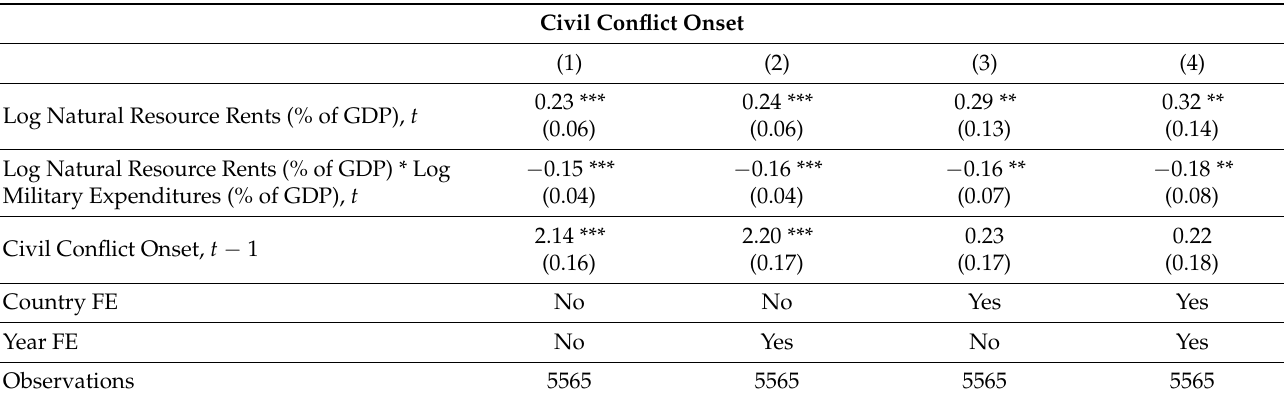
Table 7. Robustness: Controlling for Lagged Civil